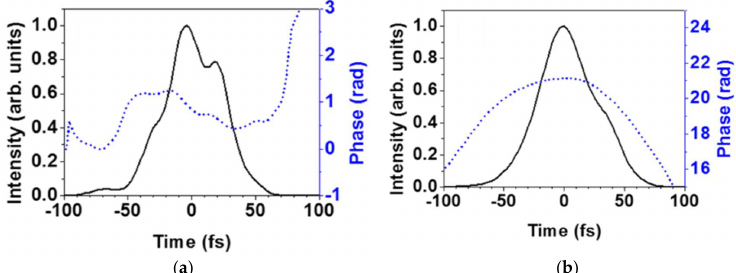
Figure 7. Retrieved temporal intensity (solid line) and phase (broken line) profiles of ( a ) pulse A and ( b ) pulse B. Appl. Sci. 2016 , 6 , 315